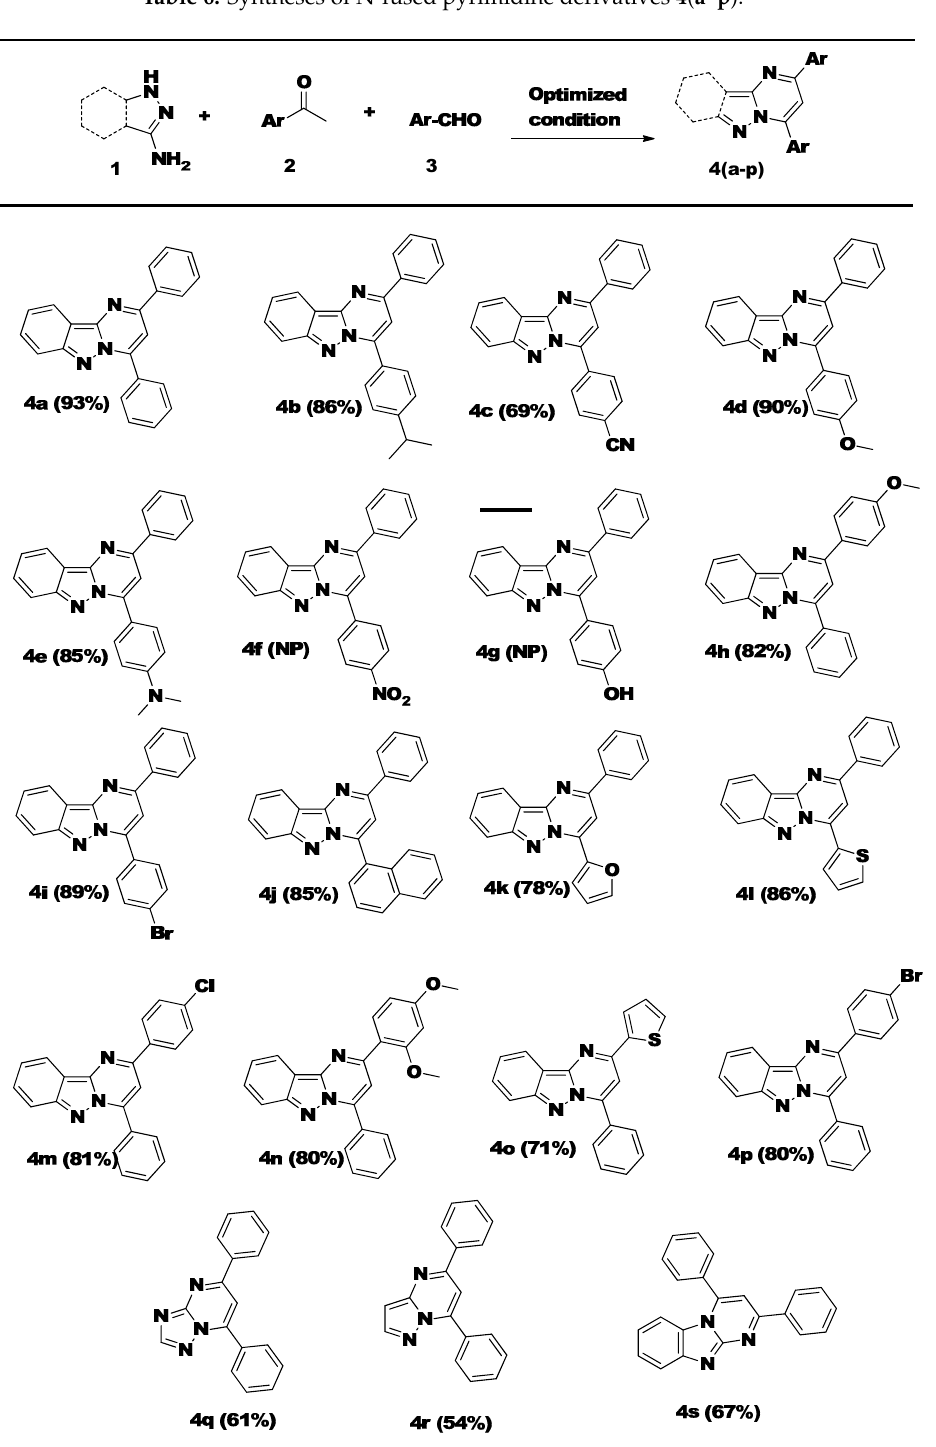
Table 6. Syntheses of N-fused pyrimidine derivatives 4 ( a – p